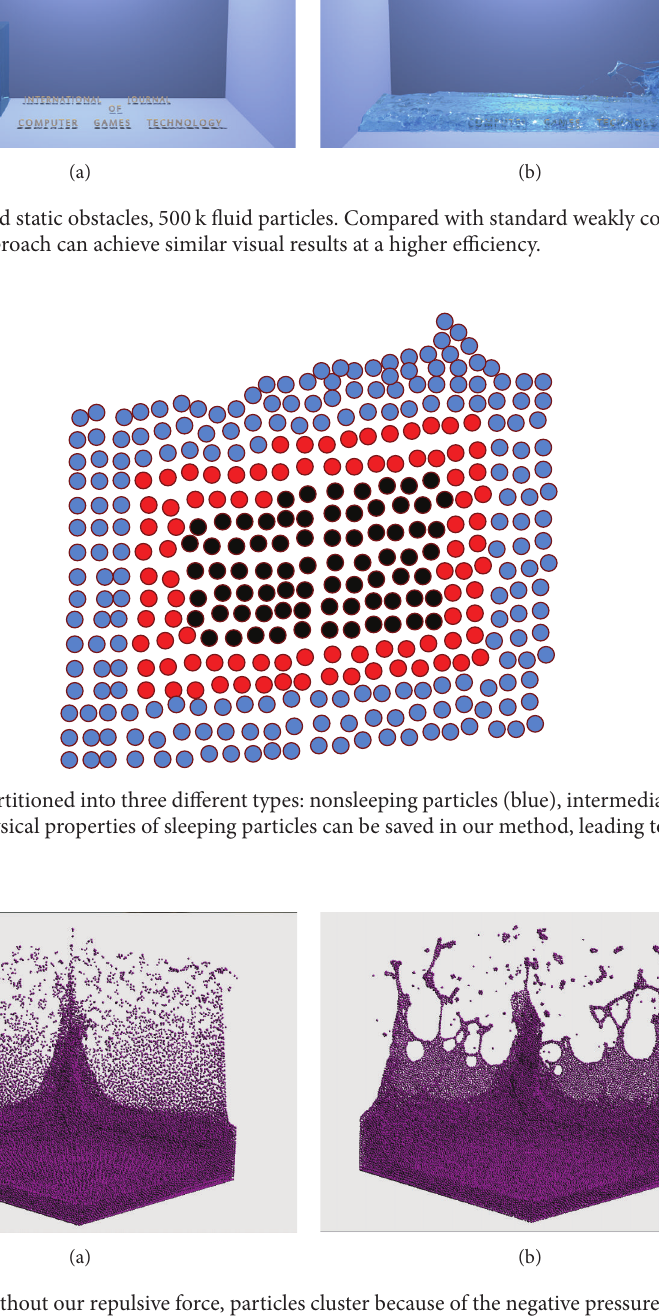
Figure 3: Tensile instability. (a) Without our repulsive force, particles cluster because of the negative pressures. (b) With our repulsive force, particles distribute more uniformly with our artificial repulsive force. This example also shows that our method can generate surface tension like effects, as can be seen from (b).